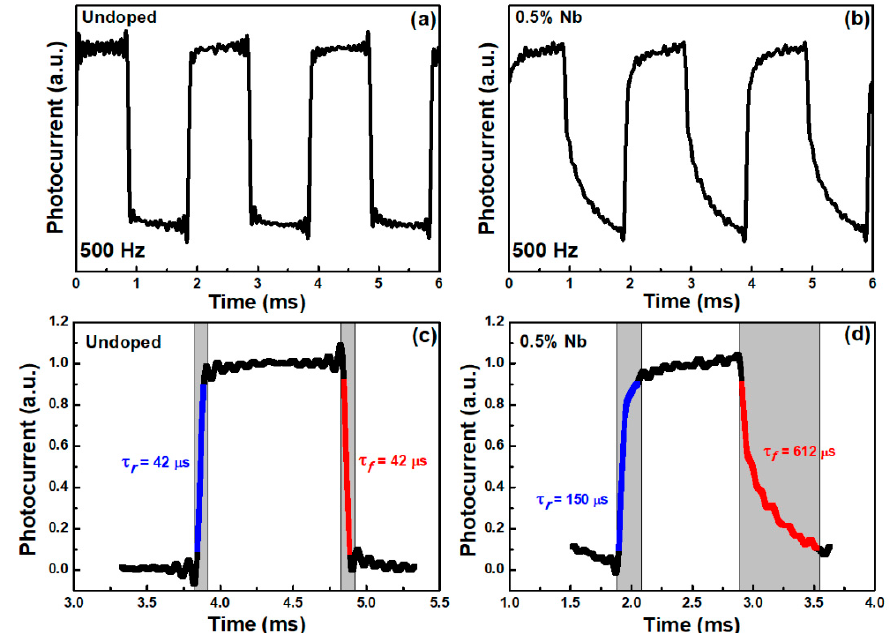
Figure 4. Time-resolved photoresponse of ( a ) undoped and ( b ) 0.5% Nb-doped WSe 2 -layered crystals at 500 Hz. The enlarged and normalized plots of ( c ) undoped and ( d ) 0.5% Nb-doped WSe 2 -layered crystals of one response cycle for calculating the rise and fall times.